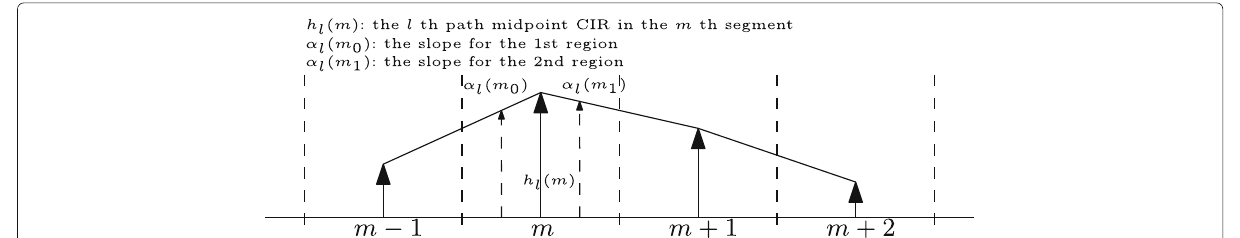
Fig. 1 The diagram of the piecewise linear model for the time-varying